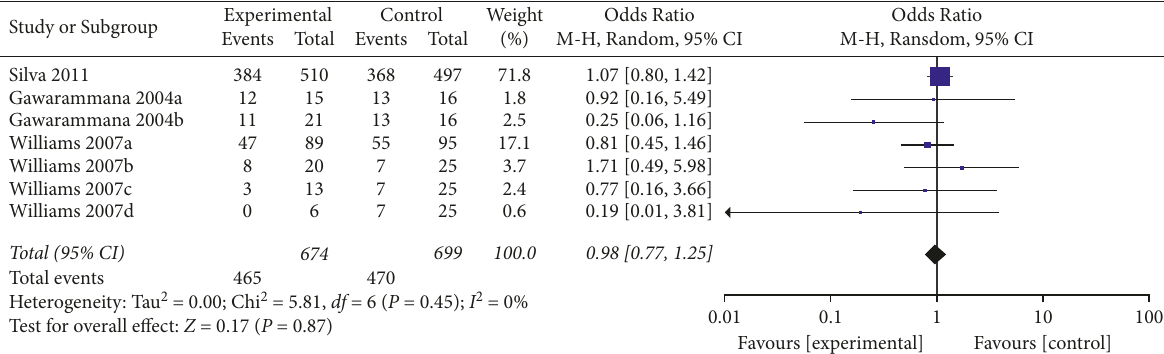
Figure 3: Sensitivity analysis of ADRs associated with antivenom use following snakebite between the prehydrocortisone with or without other drugs groups and the placebo or no premedication groups in seven comparisons from three studies.